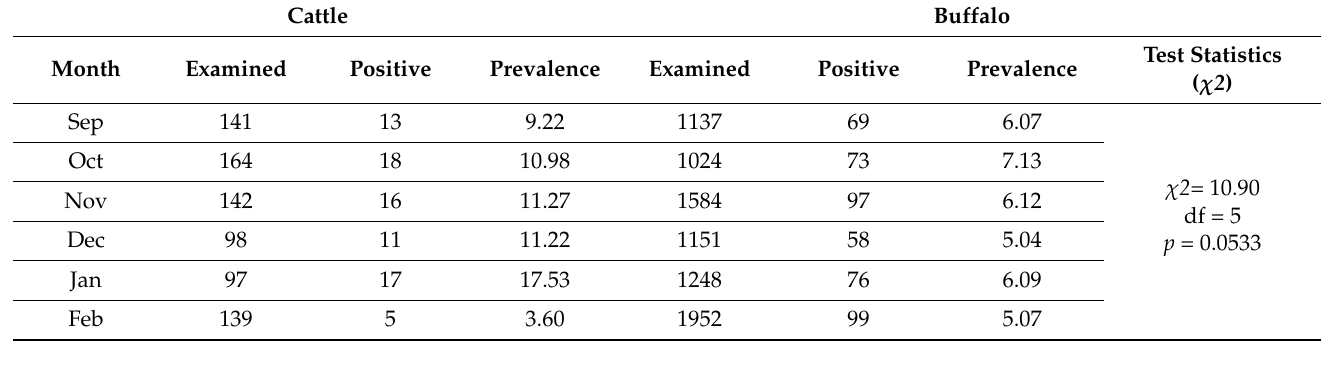
Table 2. Monthly prevalence of hydatid cysts in slaughtered animal species.